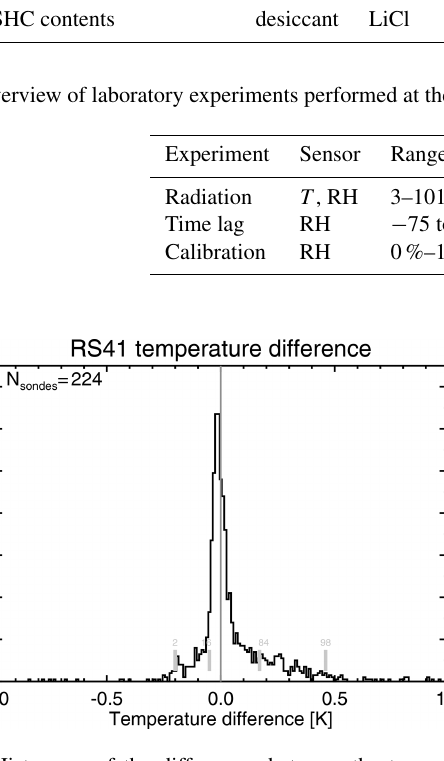
Figure 5. Histograms of the differences between the RH value recorded by the RS41 and the reference value at room temperature in the standard humidity chamber (Table 3) from tests that were performed between 2014 and 2018. The black trace represents the histogram of all measurements, and the colored traces represent the histograms for the reference RH values of 0%RH (blue), 11%RH (green), 33%RH (red), 75%RH (light blue), and 100%RH (or- ange). Data are collected in 0.1%RH